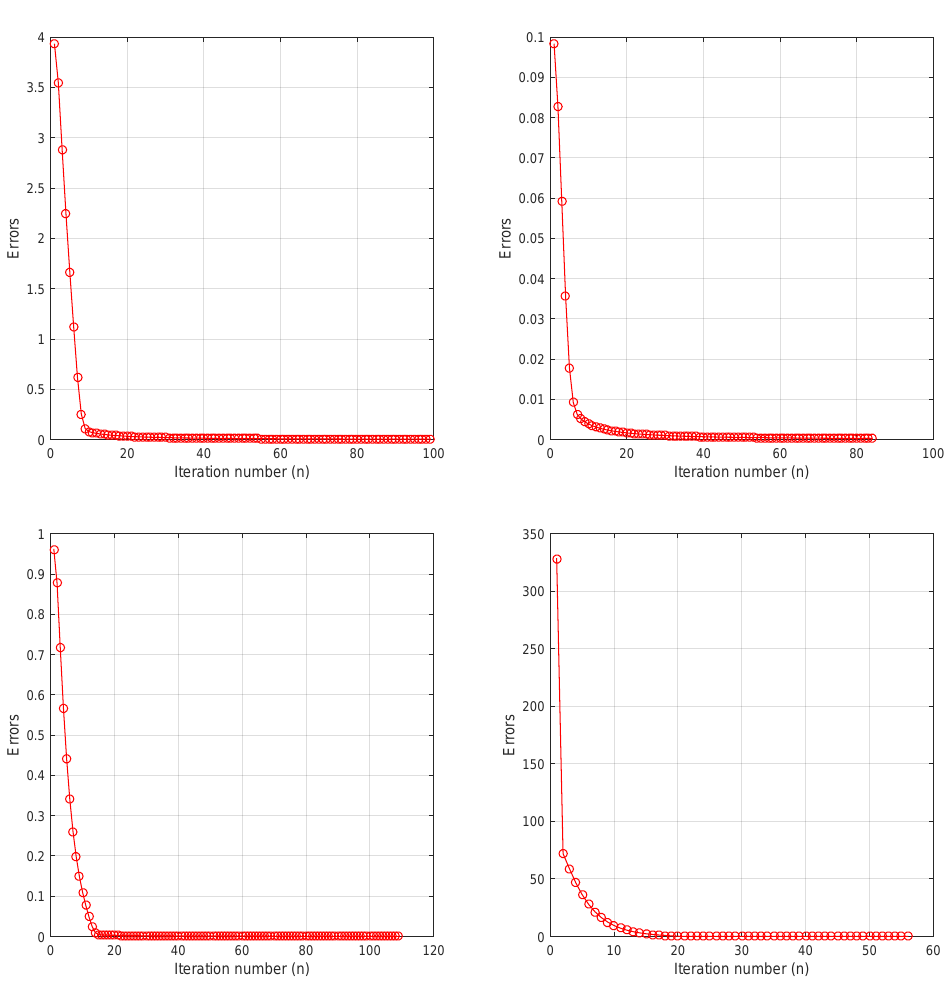
Figure 2: Example 5.2: Top Left Case 1; Top Right: Case 2; Bottom Left: Case 3; Bottom Right: Case